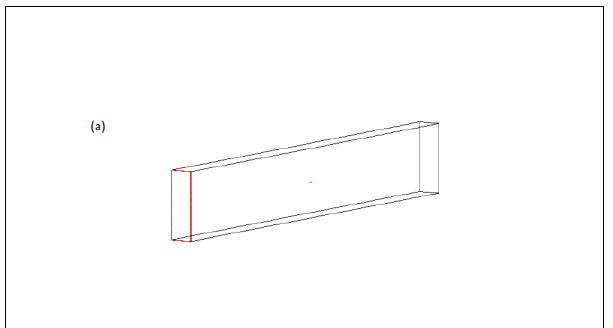
Fig 1. Simulated cube geometry (a) and average output pulse shapes (b) for neutron (blue) and gamma (red) radiation. The dimensions of the cube are 5 cm x 5 cm x 5 cm.